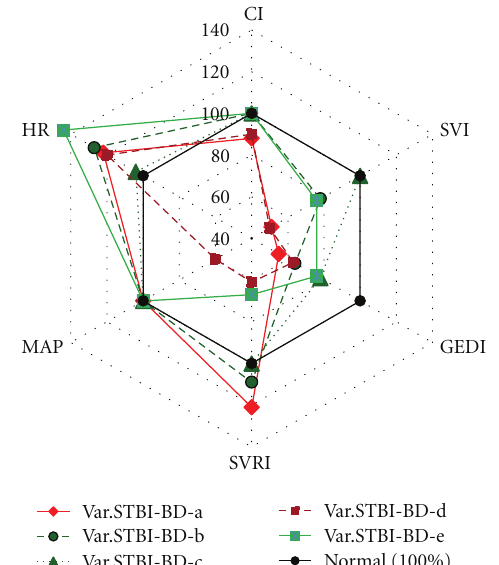
Figure 2: Variants of hemodynamic reaction in the patients of group STBI-BD on the first day. Note. Hemodynamic parameters are presented with percents from the normal value.